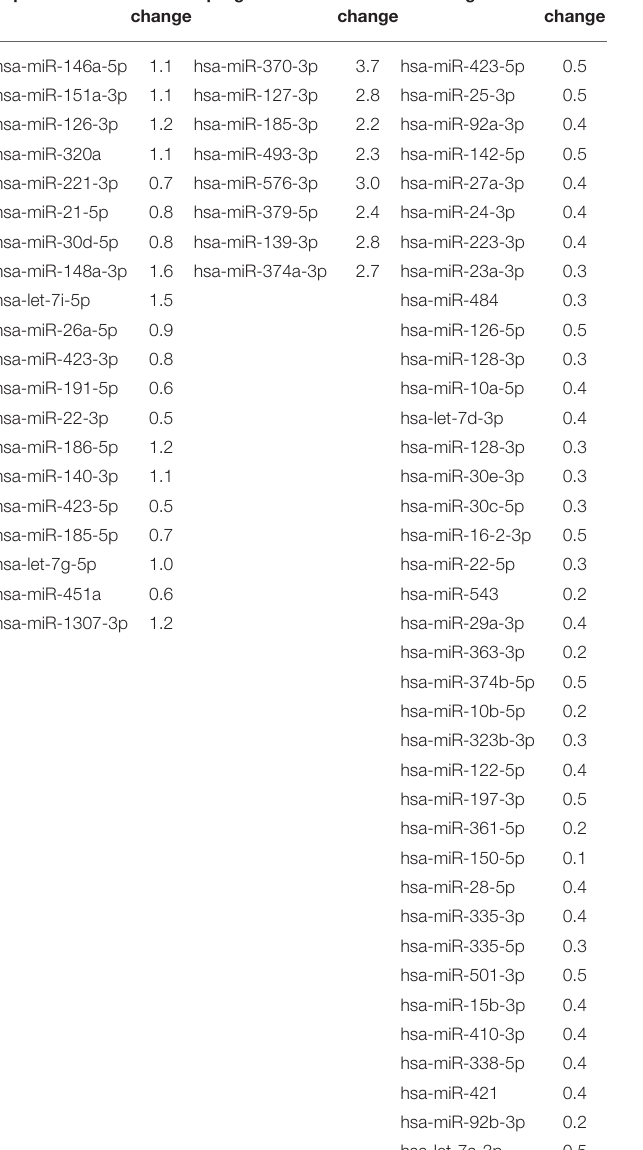
TABLE 1 | Impact of Mirasol treatment on the microRNA profile of platelet-derived MPs. Top 20 Fold changeUpregulated Fold changeDownregulated